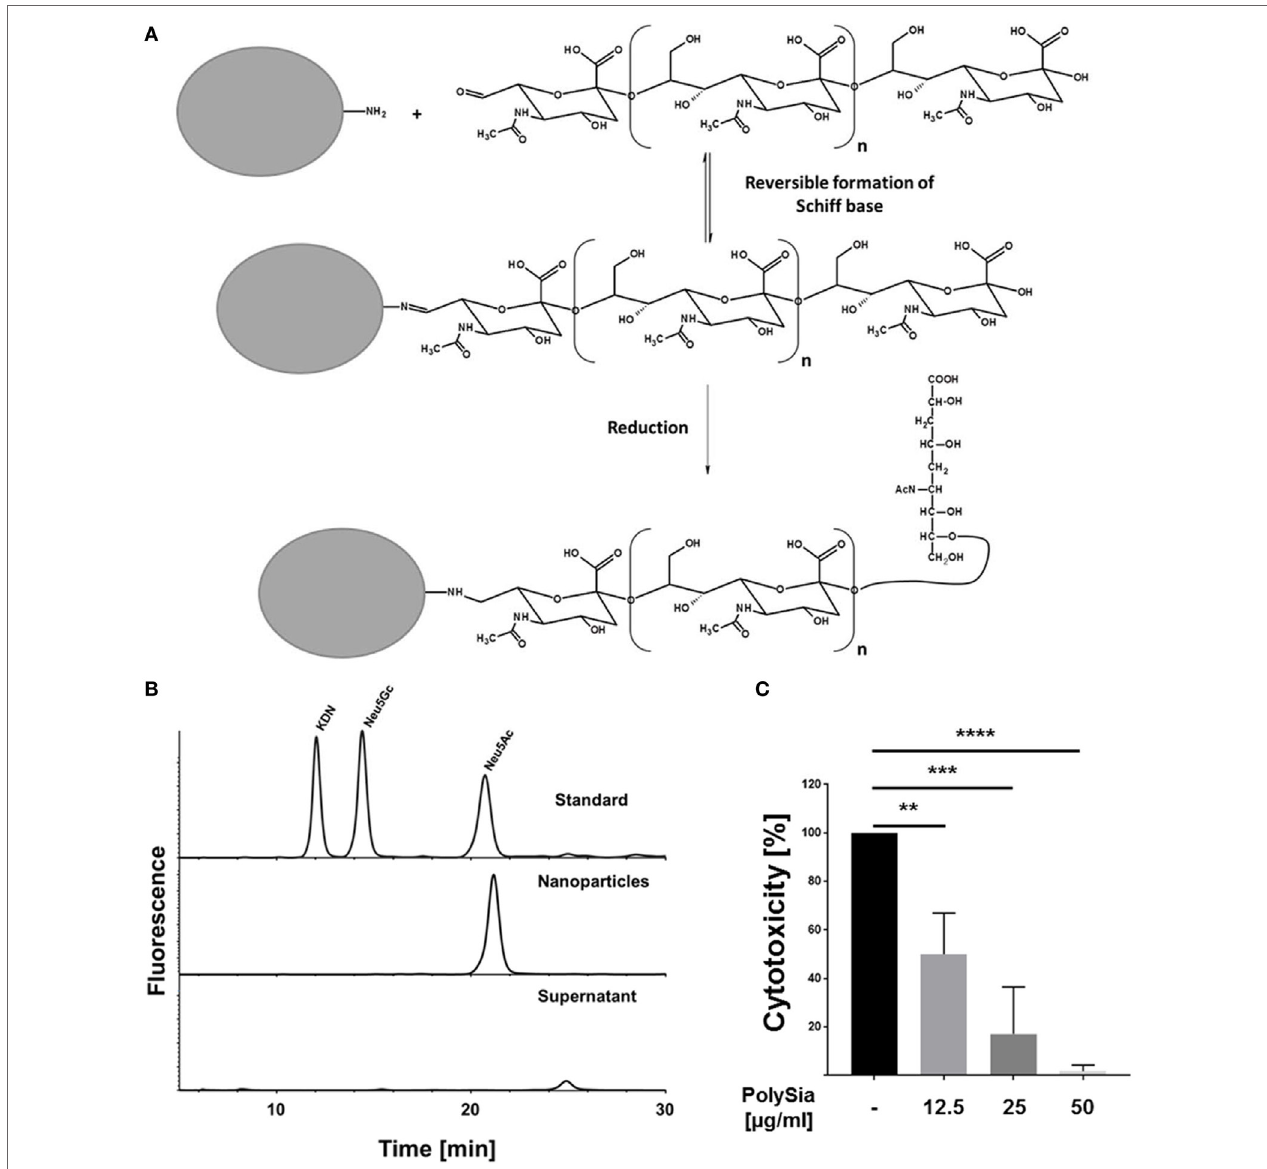
FigUre 4 | Polysialylated nanoparticles counteract histone-mediated cytotoxicity. (a) Illustration of the chemical polysialylation on amino modified particles. (B) The sialidases sensitivity of the oxidized polySia chains on nanoparticles were tested using bacterial sialidases. After enzymatic treatment, beads were centrifuged and supernatant as well as the bead-pellet were checked for the presence of Neu5Ac by DMB-HPLC analysis. A sialic acid standard panel (KDN, Neu5GC, and Neu5Ac) was used to determine the retention time of Neu5Ac. (c) In addition, polysialylated nanoparticles were tested for their capability to compensate histone-mediated cytotoxicity. Cells were treated with histones (60 µg/ml) and the cytotoxicity was determined. In parallel, the cytotoxicity was determined in the presence of different concentration of polysialylated nanoparticles. 100% cytotoxicity was set for histone-treated cells. All values are means of three independent experiments. The statistical evaluation was performed by one-way analysis of variance analysis. ns, not significant; * p < 0.05; ** p < 0.01; *** p < 0.001; **** p <